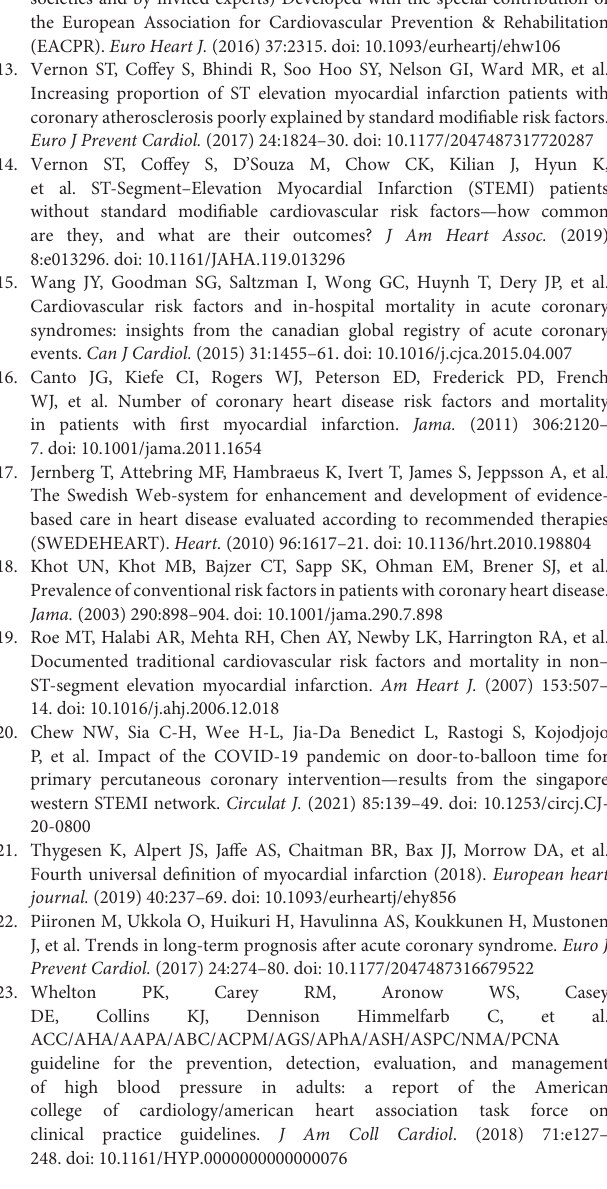
Supplementary Figure 1 | Flow chart of study population. Supplementary Figure 2 | Kaplan–Meier curves for the 30-day cardiovascular mortality in all patients presenting with AMI, with subgroup analysis based on sex, ethnicity, and AMI